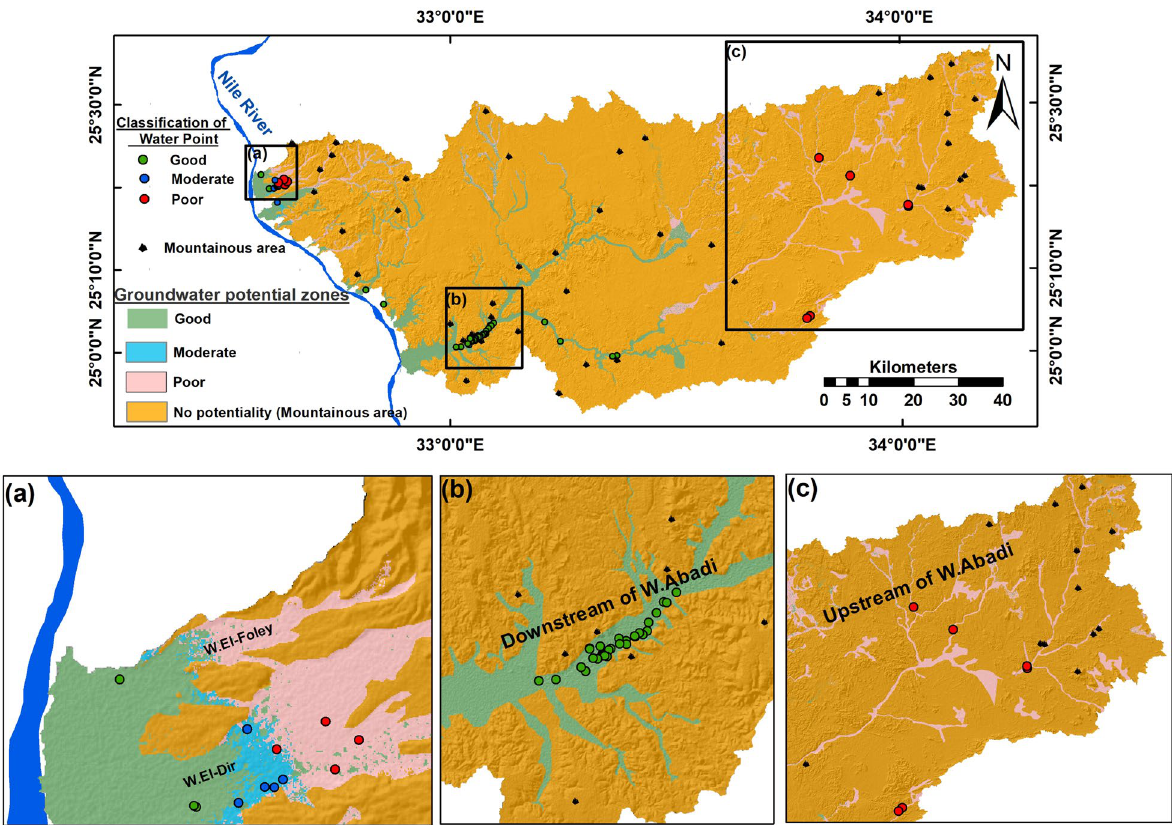
Fig. 8 GWPM derived from RF classification model associated with classification of dependent points: a zoom in Esna area; b zoom in downstream of Wadi Abadi; c zoom in upstream of Wadi